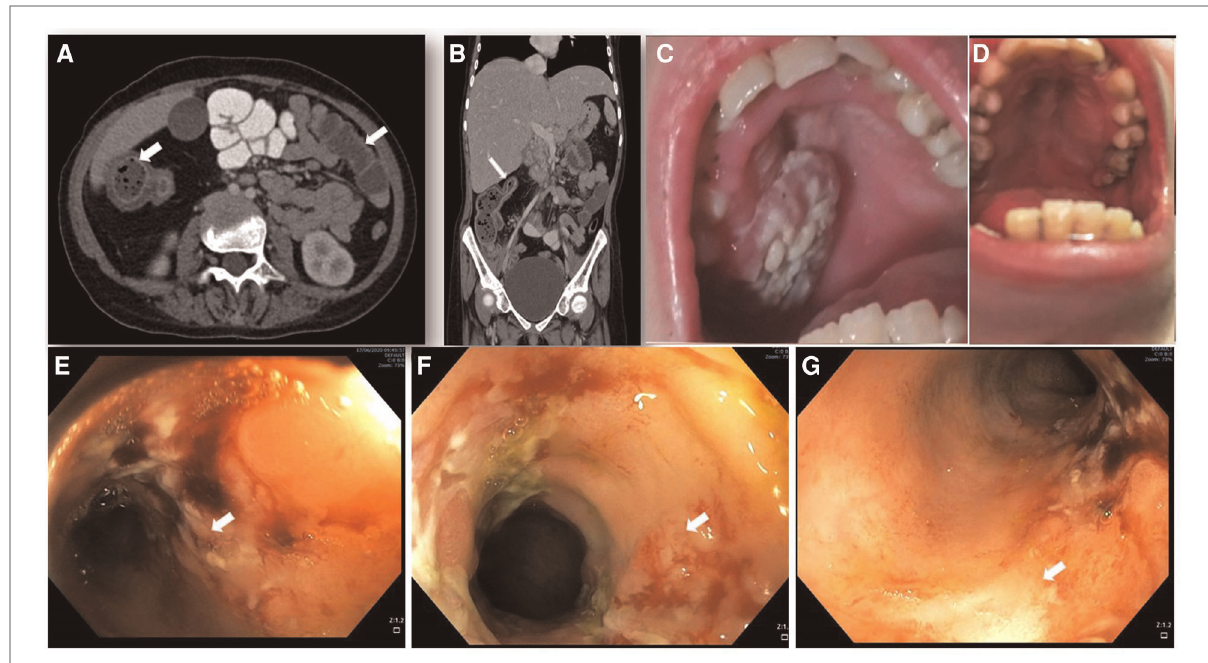
FIGURE 1 Abdominal imaging, endoscopy and clinical features. ( A,B ) abdominal computed tomography (CT) with contrast enhancement. ( A ) horizontal plane displaying the increased wall thickness of the ascending and transverse colon (arrows). ( B ) coronal plane demonstrating stricture of the transverse colon lumen (arrow). ( C ) oral sores and lesions before EMPA treatment and ( D ) its resolution after 12 months of treatment. ( E – G ) colonoscopy showing IBD-like colitis involving descending ( E ), ascending ( F ) and transverse ( G ) colon with severe in fl ammation, fi brin plaques, and mucosal ulcers (white arrows) and skip lesions with areas of Normal mucosa.